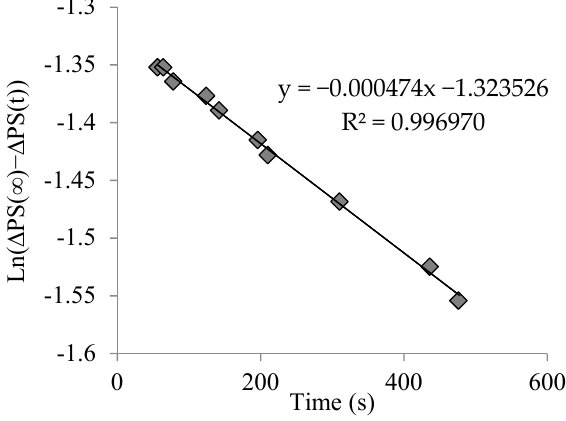
y = − 0.000474x − 1.323526 R² = 0.996970